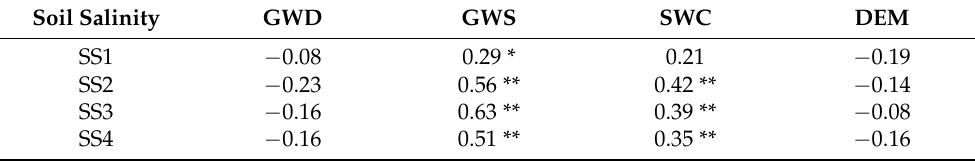
Table 3. Pearson’s correlation matrix between soil salinity and environmental